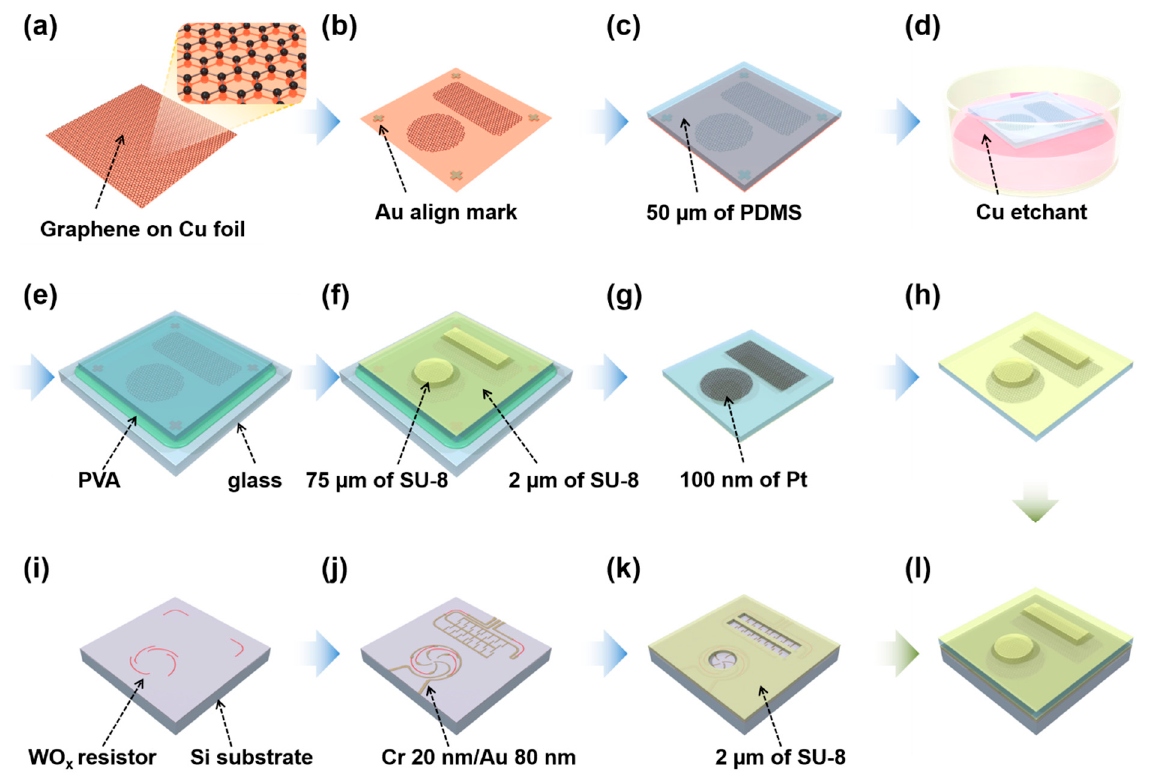
Sensors 2021 , 21 , 4274 Figure 2. The fabrication process of TIS: ( a ) graphene grown on Cu foil; ( b ) align mark deposition and graphene patterning; ( c ) PDMS molding; ( d ) Cu foil etching; ( e ) fixing PDMS layer to glass substrate using PVA; ( f ) forming bump and ridge structure; ( g ) Pt deposition; ( h ) fabricated top layer; ( i ) WO x resistor formation; ( j ) electrode deposition; ( k ) spacer formation; ( l ) combining with fabricated top layer and bottom substrate.